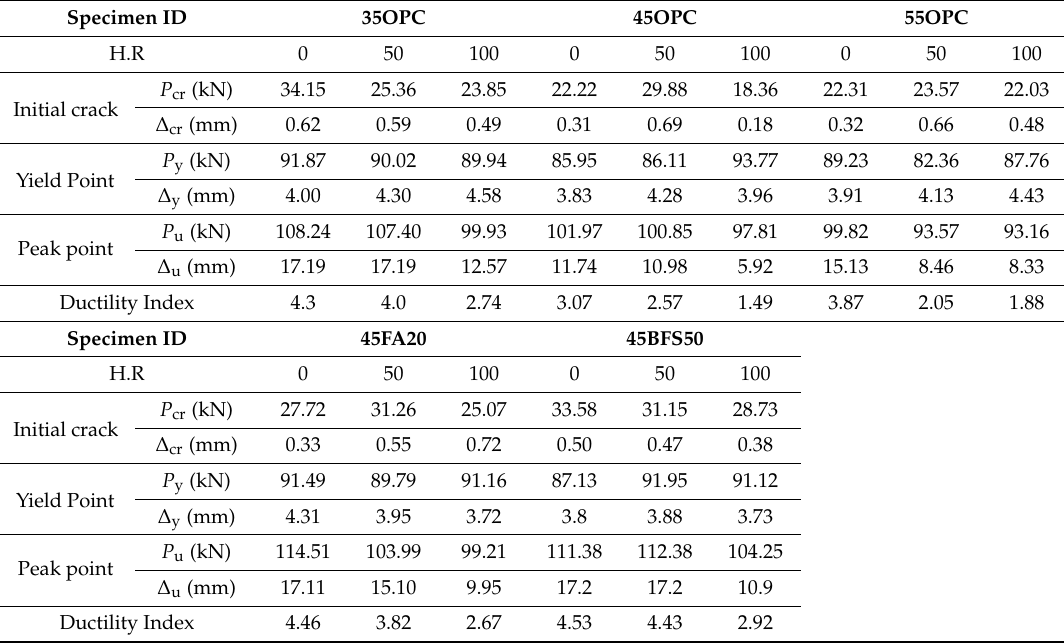
Figure 5. Load-displacement curves for RC beam. Table 7. Experimental results of ductility index of RC